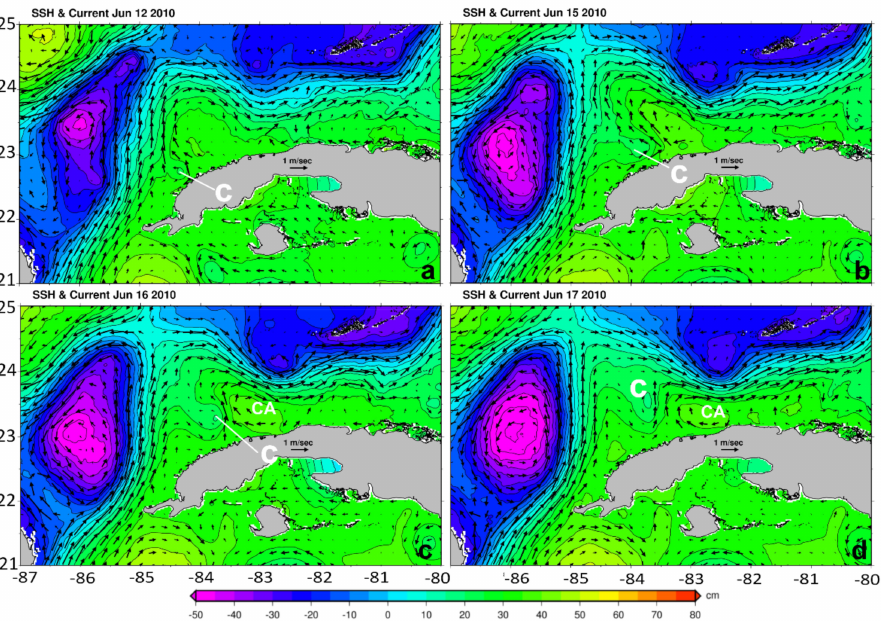
Figure 5. Maps of simulated (GoM-HYCOM 1/50 model) sea surface height (SSH) and surface current vectors (m/s) over western Straits of Florida on ( a ) 12, ( b ) 15, ( c ) 16 and ( d ) 17 June 2010 (E3 period). The cyclonic (C) and anticyclonic (CA) eddies are